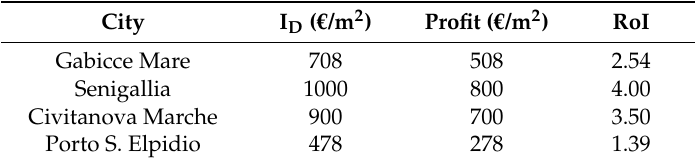
Table 9. Direct impact and Return of Investment related to the cash outlay ( € /m 2 ) of the beach nourishment for four cities along the Adriatic